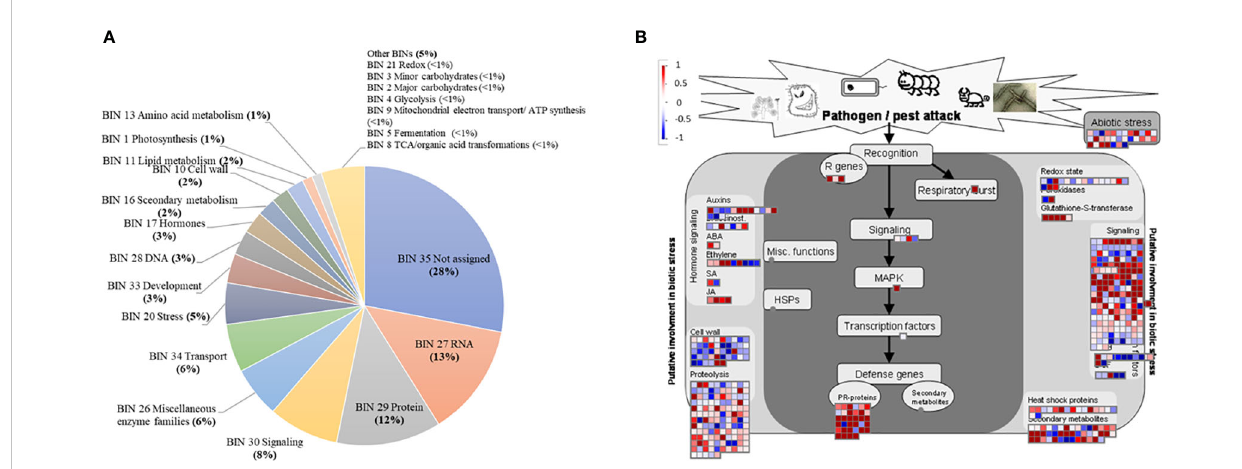
FIGURE 2 Major functional categories (BINs) using the MapMan enrichment analysis (A) ; differentially expressed genes in pathogen/pest attack category (B) , in buds of severely symptomatic Huanglongbing (HLB)-affected ‘ Hamlin ’ sweet orange trees compared to mildly symptomatic trees in February. This pathogen/pest attack category includes BINs related to hormones, redox reactions, defense genes, signaling, heat shock proteins, and biotic stress. Red and blue boxes represent upregulated and downregulated genes,